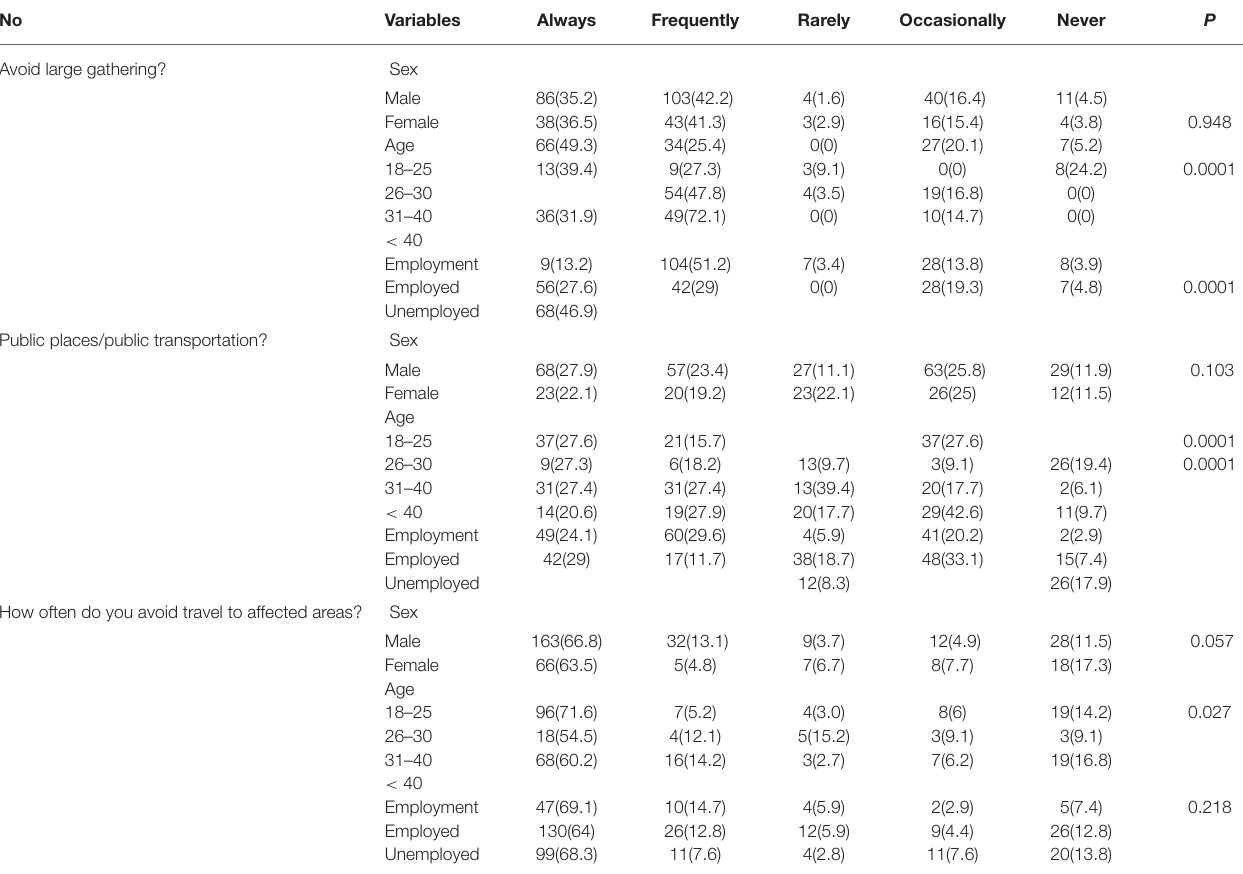
TABLE 4 | Association between demographics and social behaviors of the participants. No Variables Always Frequently Rarely Occasionally Never P Avoid large